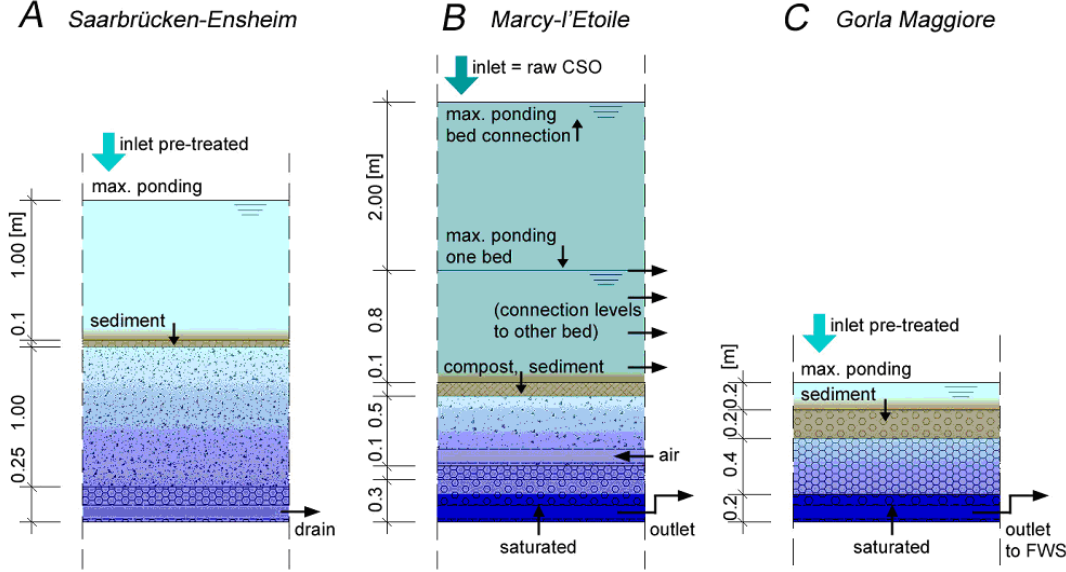
Figure 2. Simplified cross-sections of CSO-CWs in ( A ) Germany, ( B ) France; and ( C )